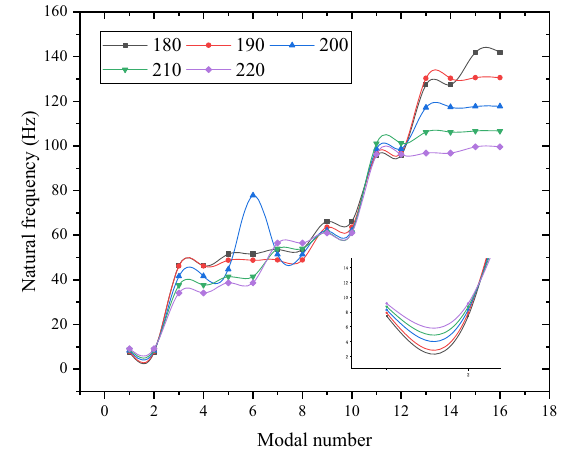
Figure 14 Effect of diameter on vibration characteristics